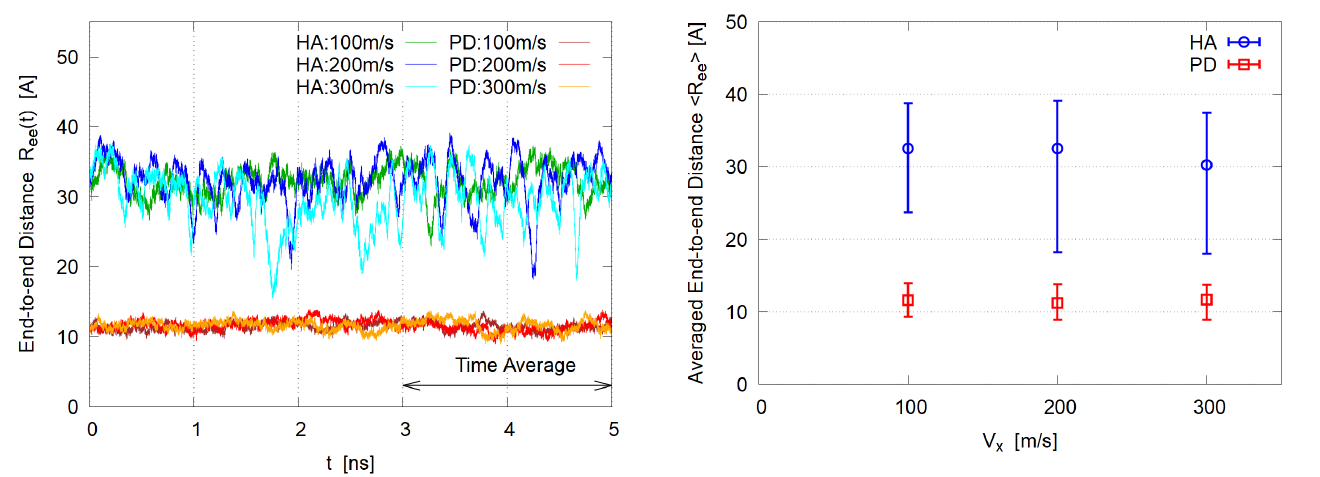
Figure 6. End-to-end distance. ( Left ) time evolution during the simulation, ( Right ) time average with minimum and maximum values for the period 3ns ≤ t ≤ 5ns.